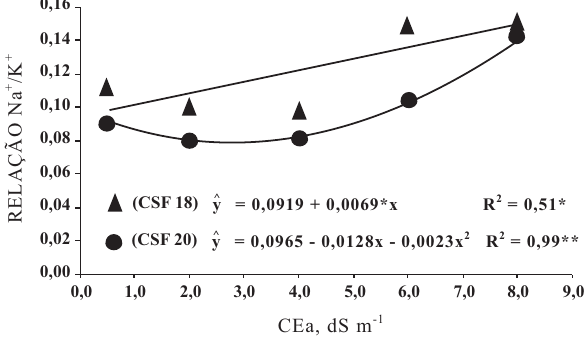
Figura 5. Relação Na + /K + nos limbos foliares em plan- tas de dois genótipos de sorgo forrageiro irrigadas com água com crescentes concentra- ções de sais e com diferentes condutividades elétricas (CEa).